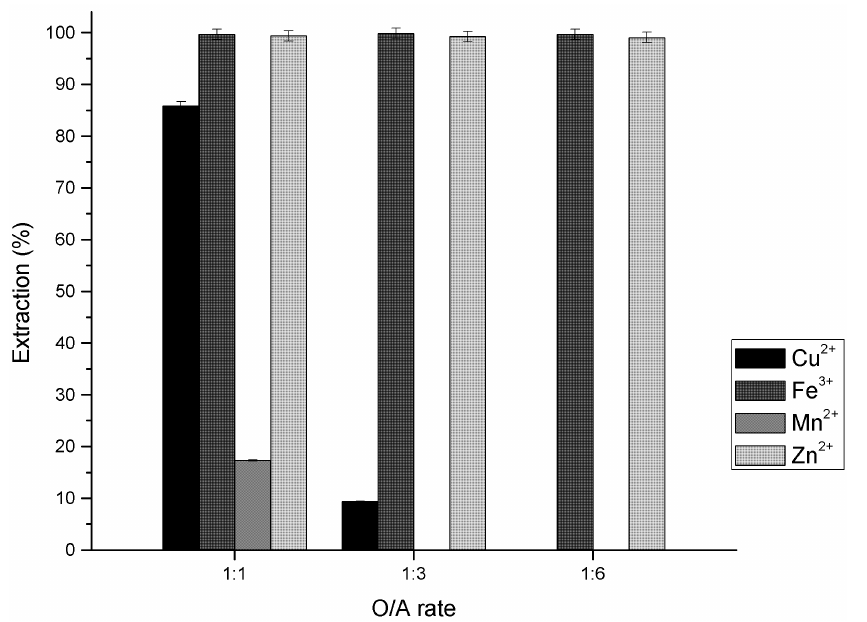
Figure 2. Effect of O/A ratio on extraction percentage of metals from aqueous solution. Experimental conditions: R 4 NCy = 0.54 M, pH = 2, 400 min − 1 , and 20 min of stirring time.